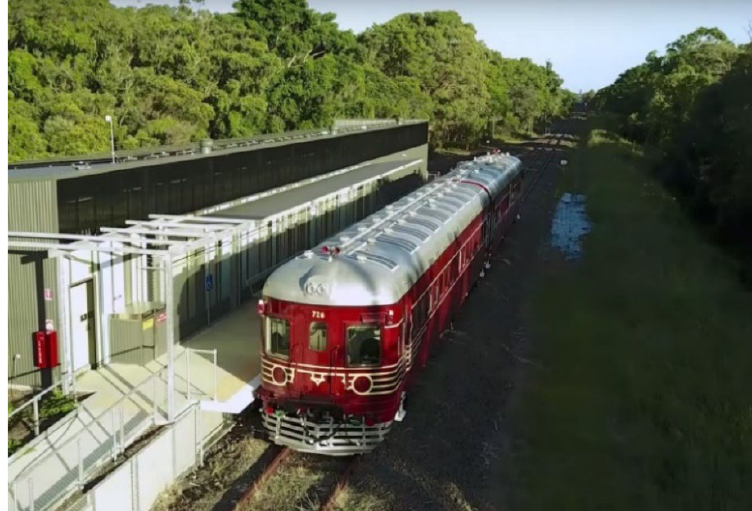
Figure 3. Australia’s train with PV solar panels [21].